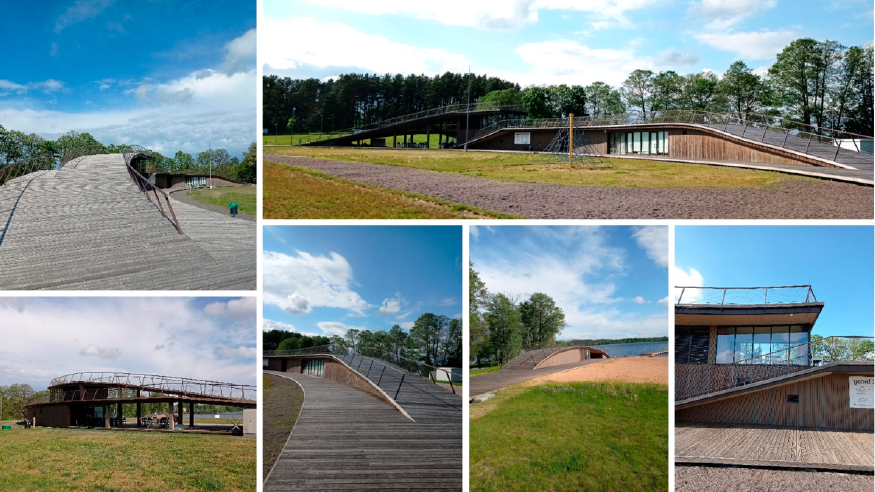
Figure 4. Recreation and Water Center in Zarasai with landscape-inspired volumes and nature-like spatial characteristics was selected as an example of organic biophilic design. Photographs by A. Daugelaite.